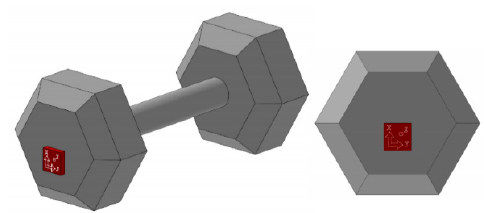
Figure 1. Prototype of hex dumbbell.